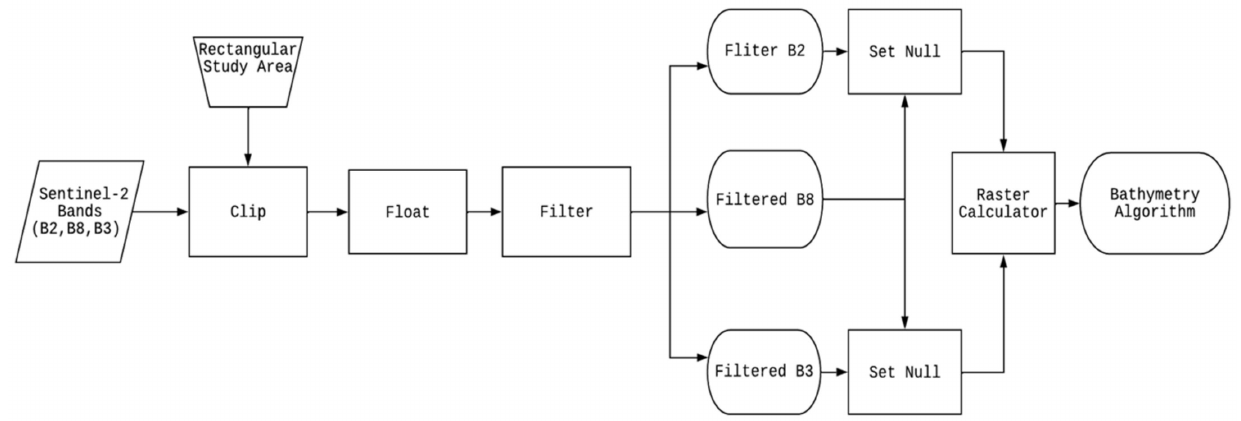
Figure 8. Modelbuilder script was developed in this study in order to automatically calculate the bathymetry in shallow waters using three bands (B2, B8, and B3) of Sentinel 2